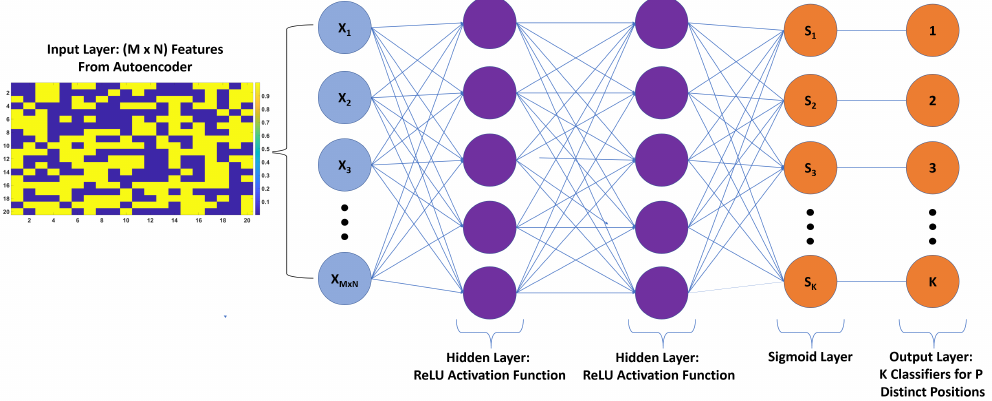
Figure 2. The proposed load localization ANN with 2 hidden layers and ReLU activation